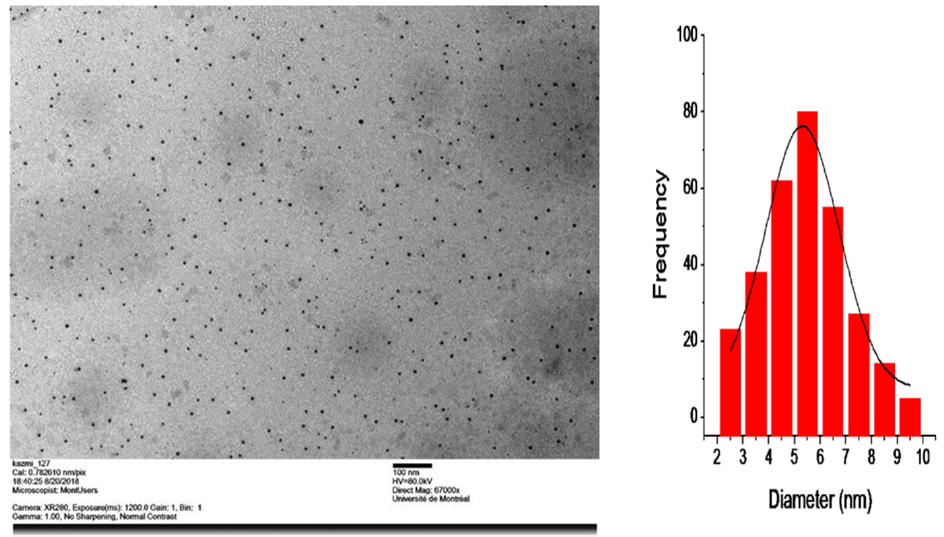
Figure 3. TEM and histogram of mino/AgNPs.